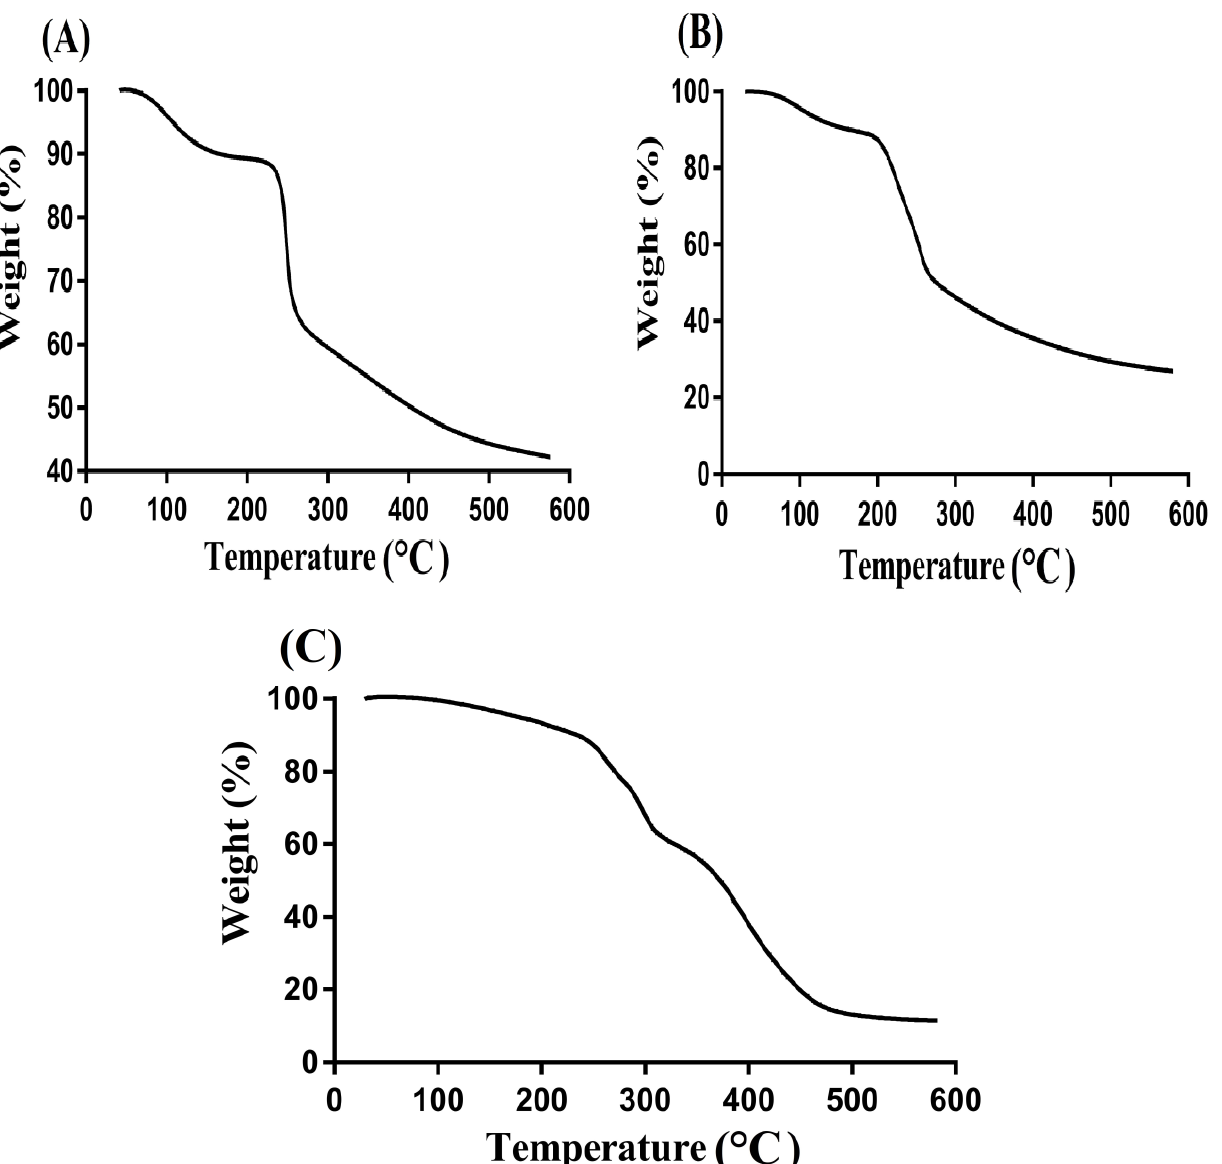
Figure 3. TGA of ( A ) CS, ( B ) Al, and ( C ) CS/Al- g -pAa hydrogels.